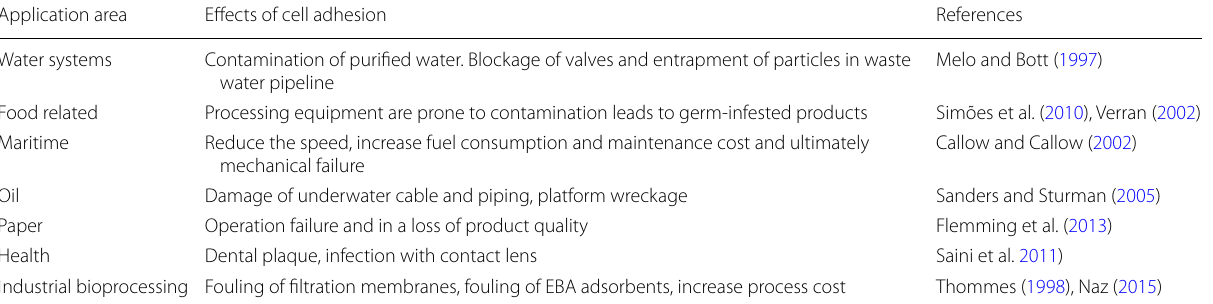
Table 1 A literature survey on effect of cell adhesion in various process applications Application